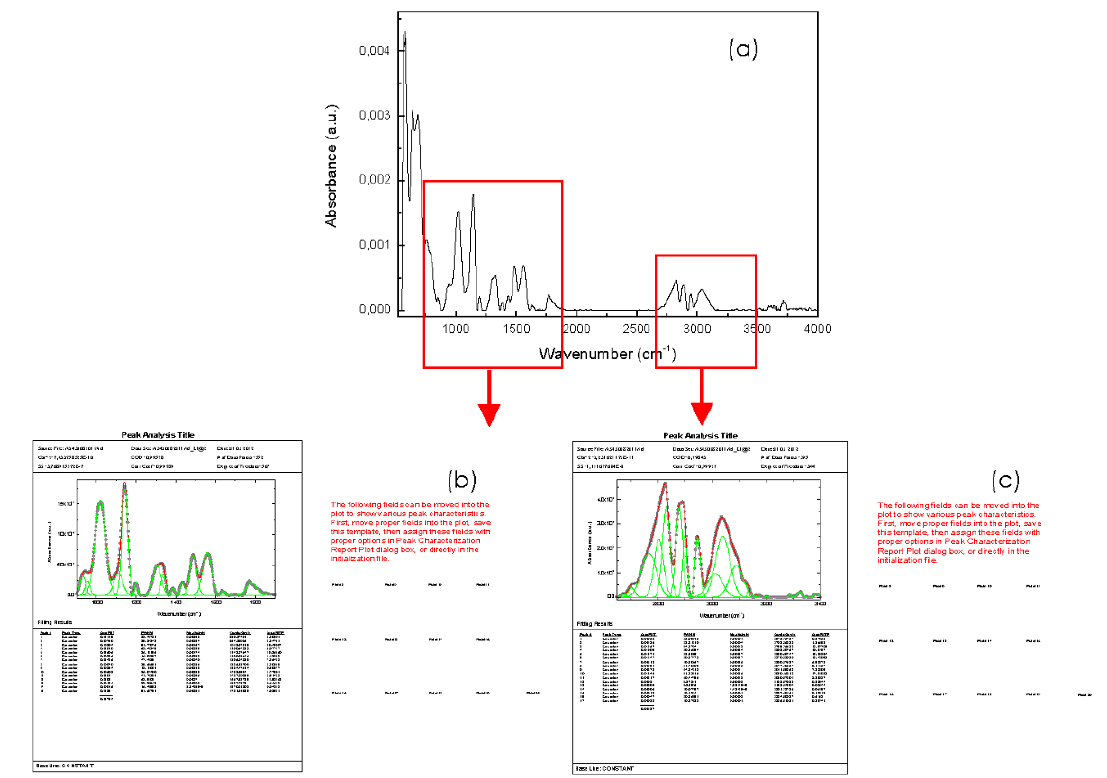
Figure 3. ATR-IR spectrum of APTES functionalized Si